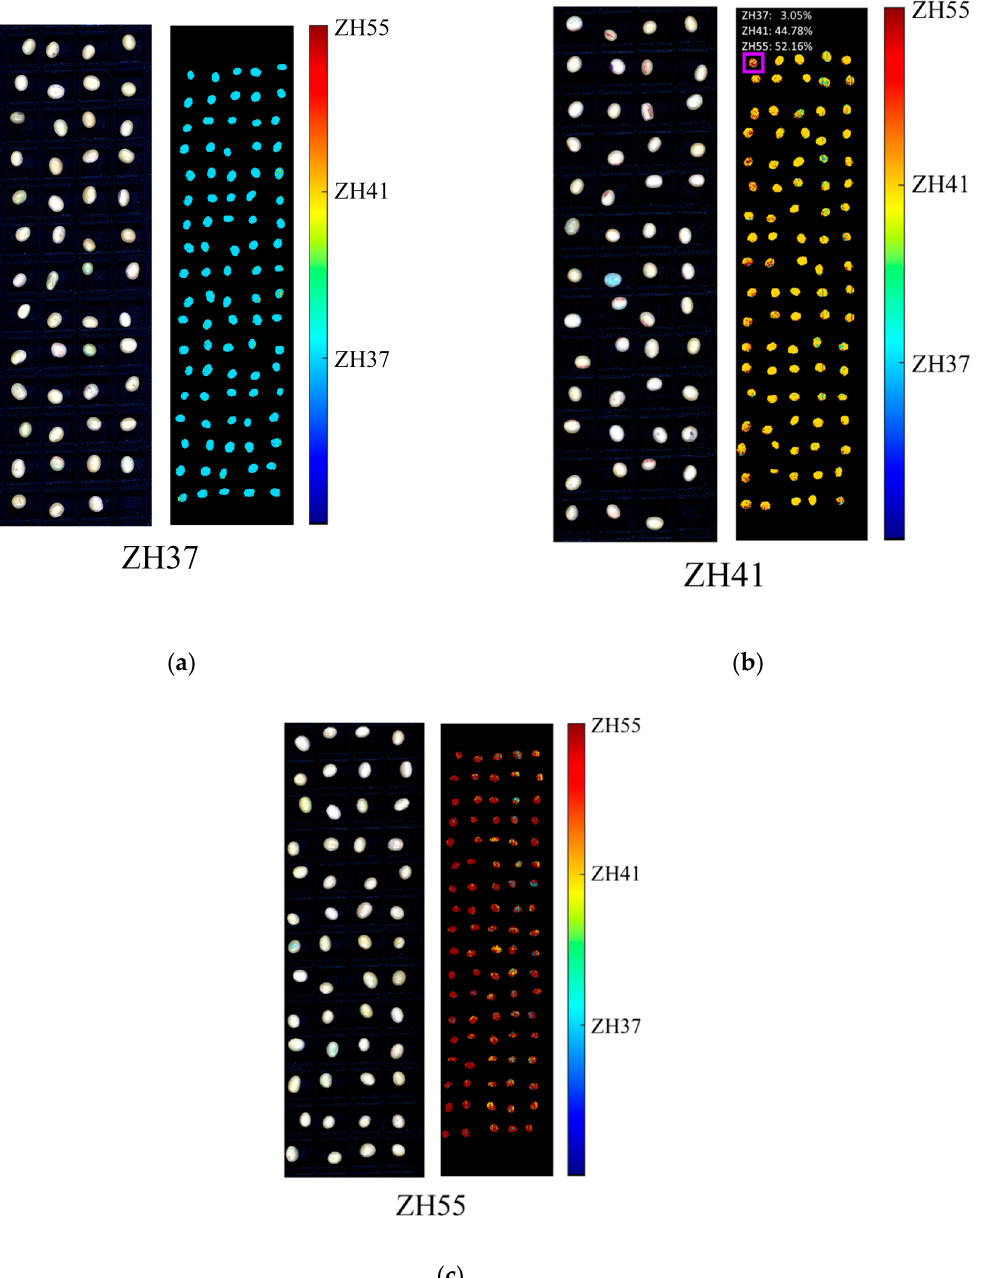
Figure 6. Pseudo-color images (1000, 1200, and 1400 nm) and prediction maps of a randomly selected image of each variety based on pixel-wise CNN models built with 60 soybeans of each variety: ( a ) ZH37, ( b ) ZH41, and ( c ) ZH55.